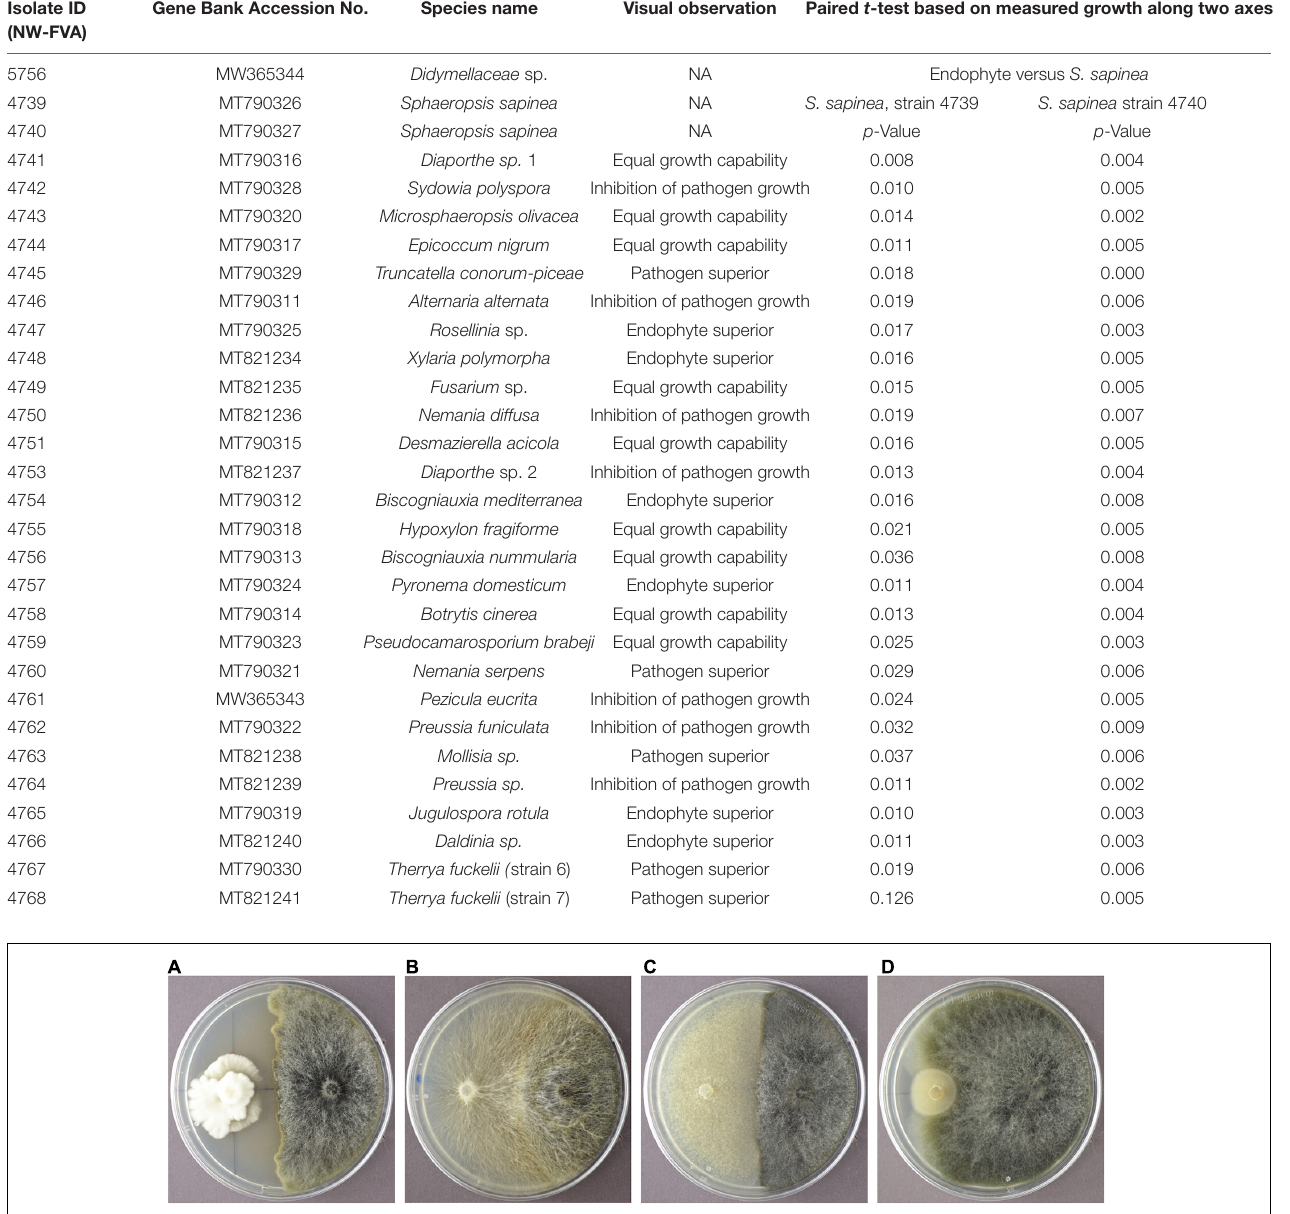
Antagonist test results